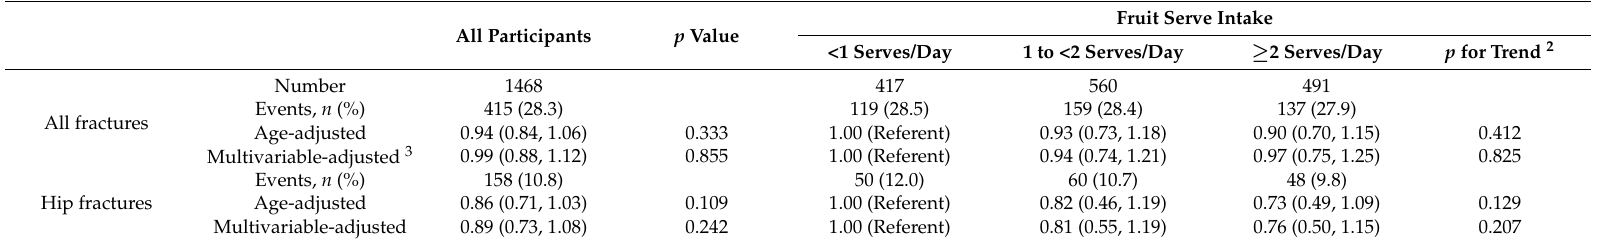
Table 5. Hazard ratios for fracture-related hospitalisation by fruit serve intake 1